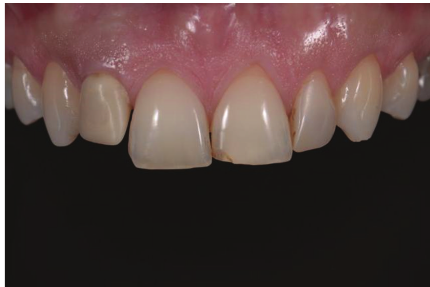
Figure 1: Initial clinical case intraoral photography.